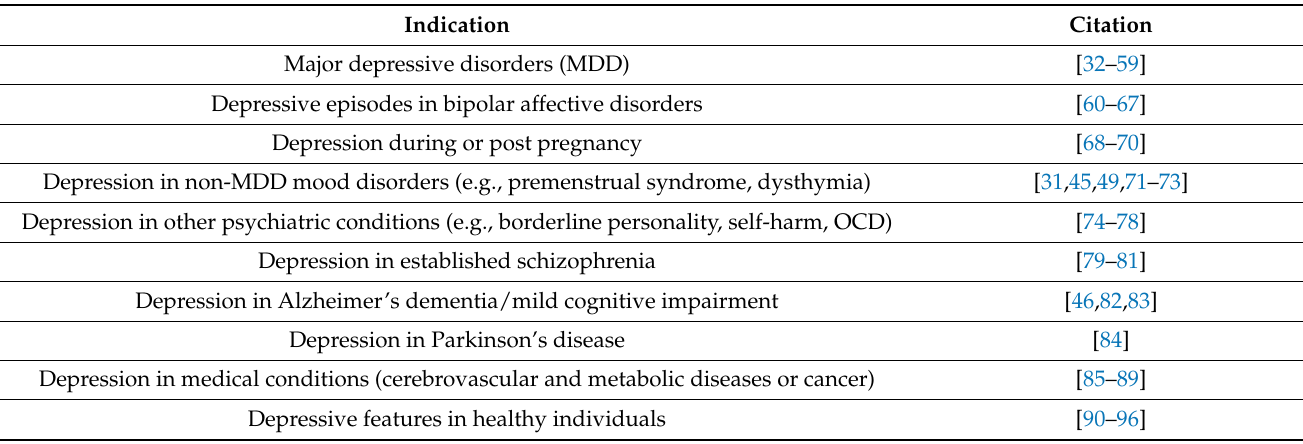
Table 1. Omega-3 RCTs in